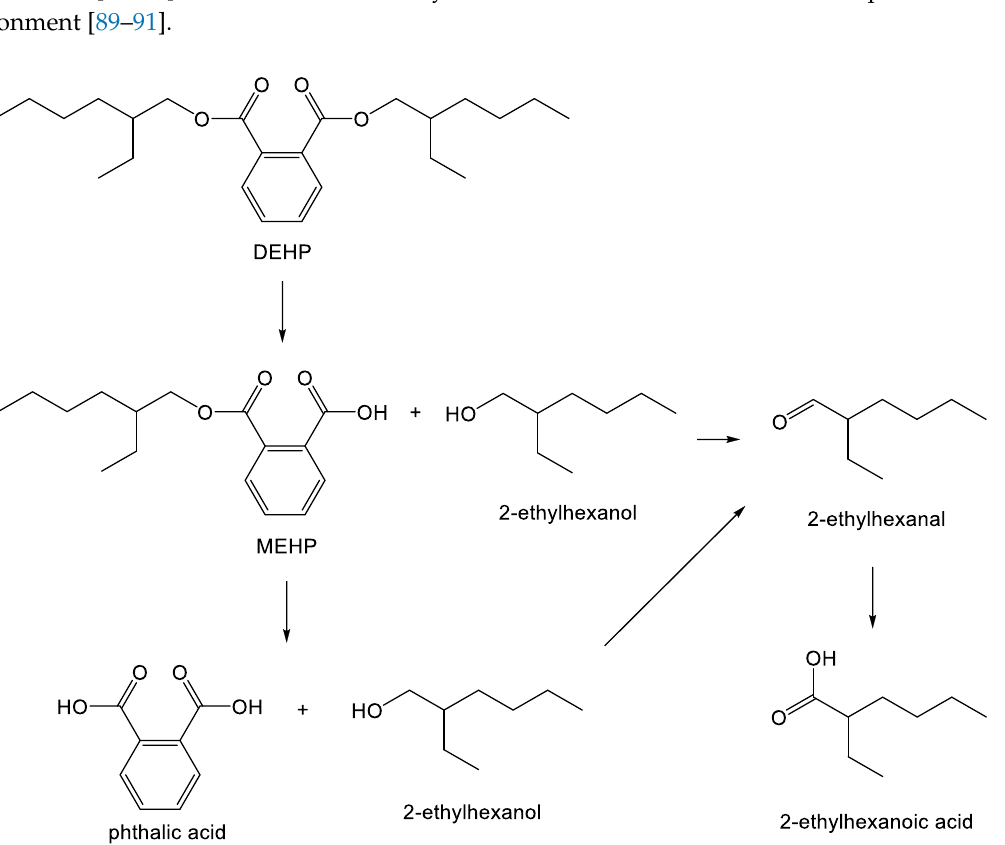
Figure 4. Biodegradation of di(2-ethylhexyl) phthalate (DEHP) through the action of esterases in microbes. Reprinted by permission from Springer Nature: Springer. Applied Microbiology and Biotechnology. Leaching of the plasticizer di(2-ethylhexyl)phthalate (DEHP) from plastic containers and the question of human exposure, Erythropel et. al., 2014 [4].